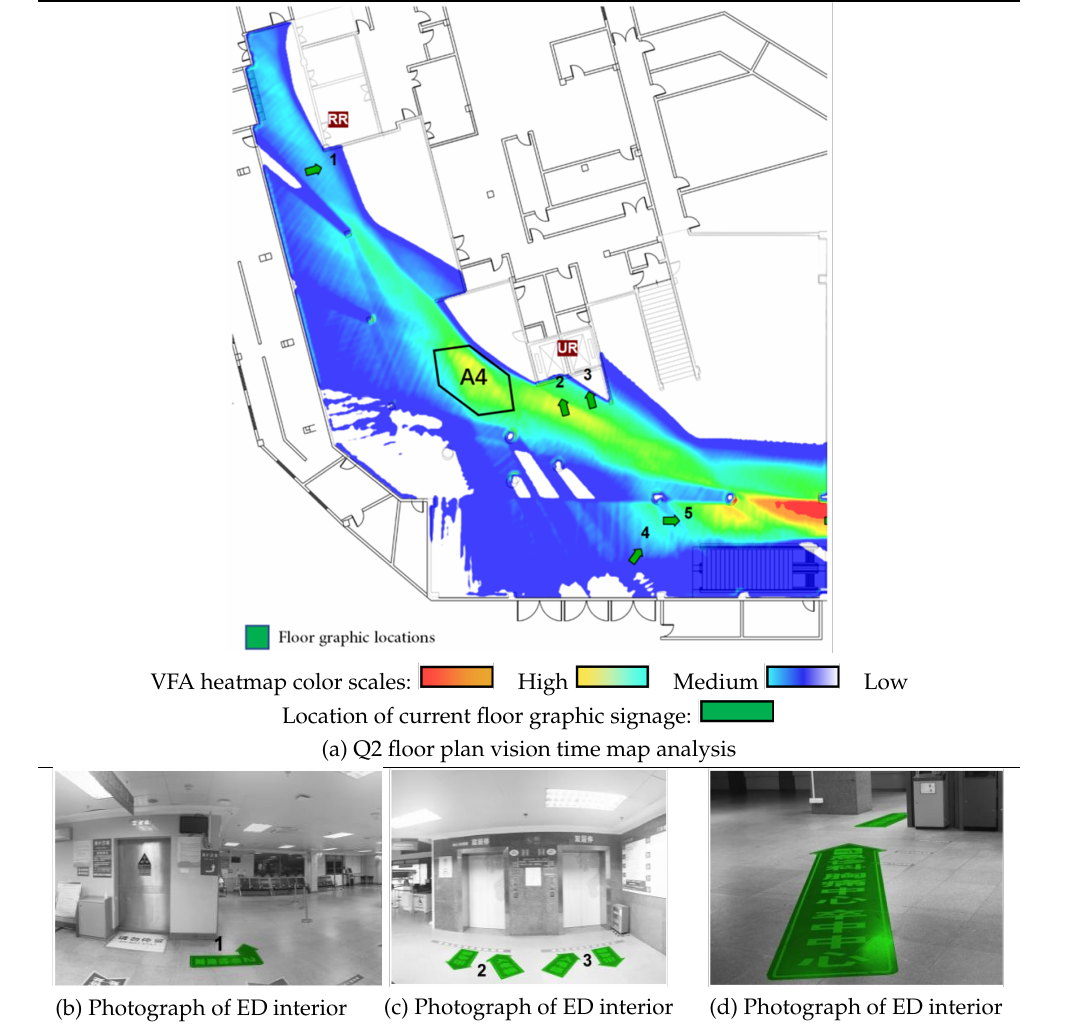
Table 23. Q2 floor graphic